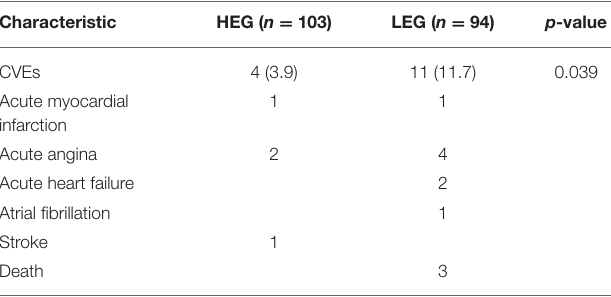
TABLE 3 | Incidence of cardiovascular events in study patients.